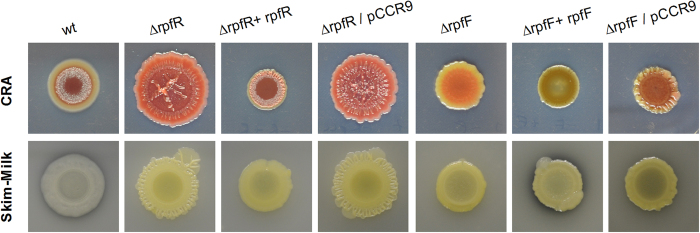
The RpfF/R QS-system controls colony morphology and protease production.Deletion of rpfR induced a rough, wrinkly colony morphology and increased EPS production on Congo red agar plates (CRA, upper panel). Both the ΔrpfR and the ΔrpfF mutant showed reduced protease production on skim-milk plates compared to the wild type (lower panel).